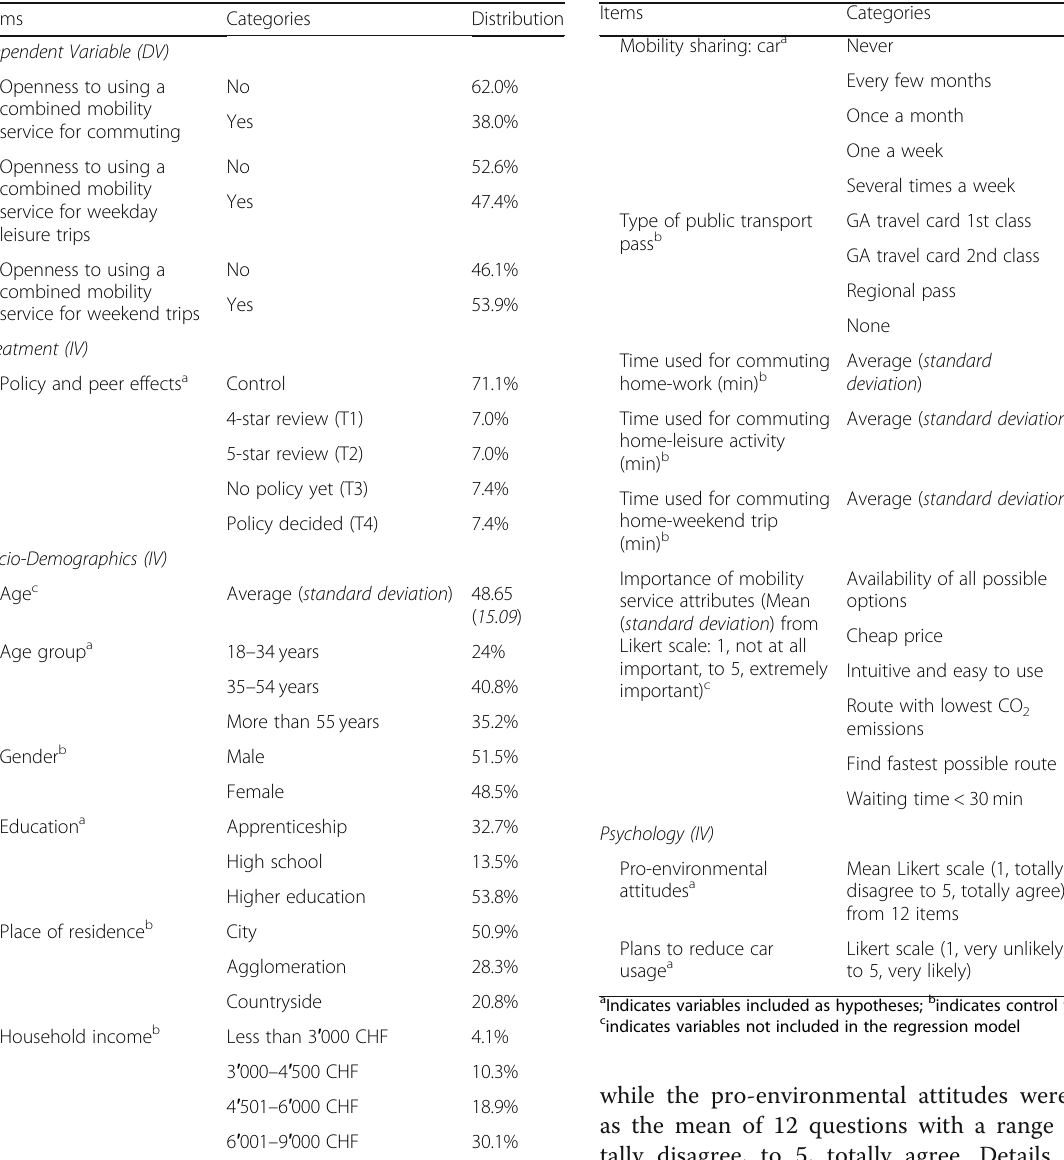
Table 3 Sample characteristics ( n =